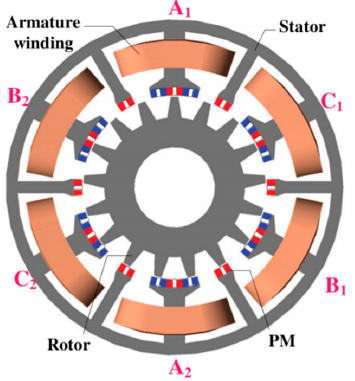
Figure 8. Configuration of an asymmetric stator pole FRPM [23].